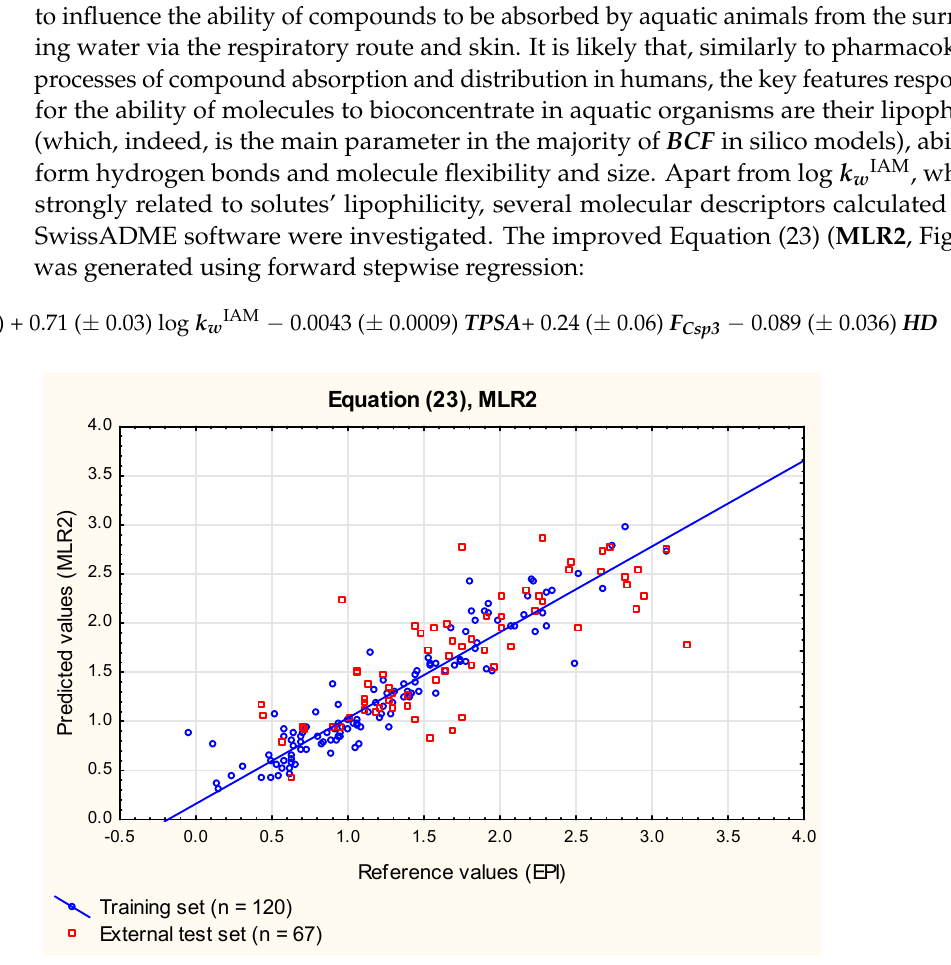
Figure 2. MLR2 model, Equation (23)—predicted vs. reference log BCF values. ( n = 120, R 2 = 0.87, R 2 adj = 0.87, RMSECV = 0.25, RMSEP ext = 0.42, RMSEP vivo = 0.27, R 2 vivo = 0.83, F = 198.4, p <